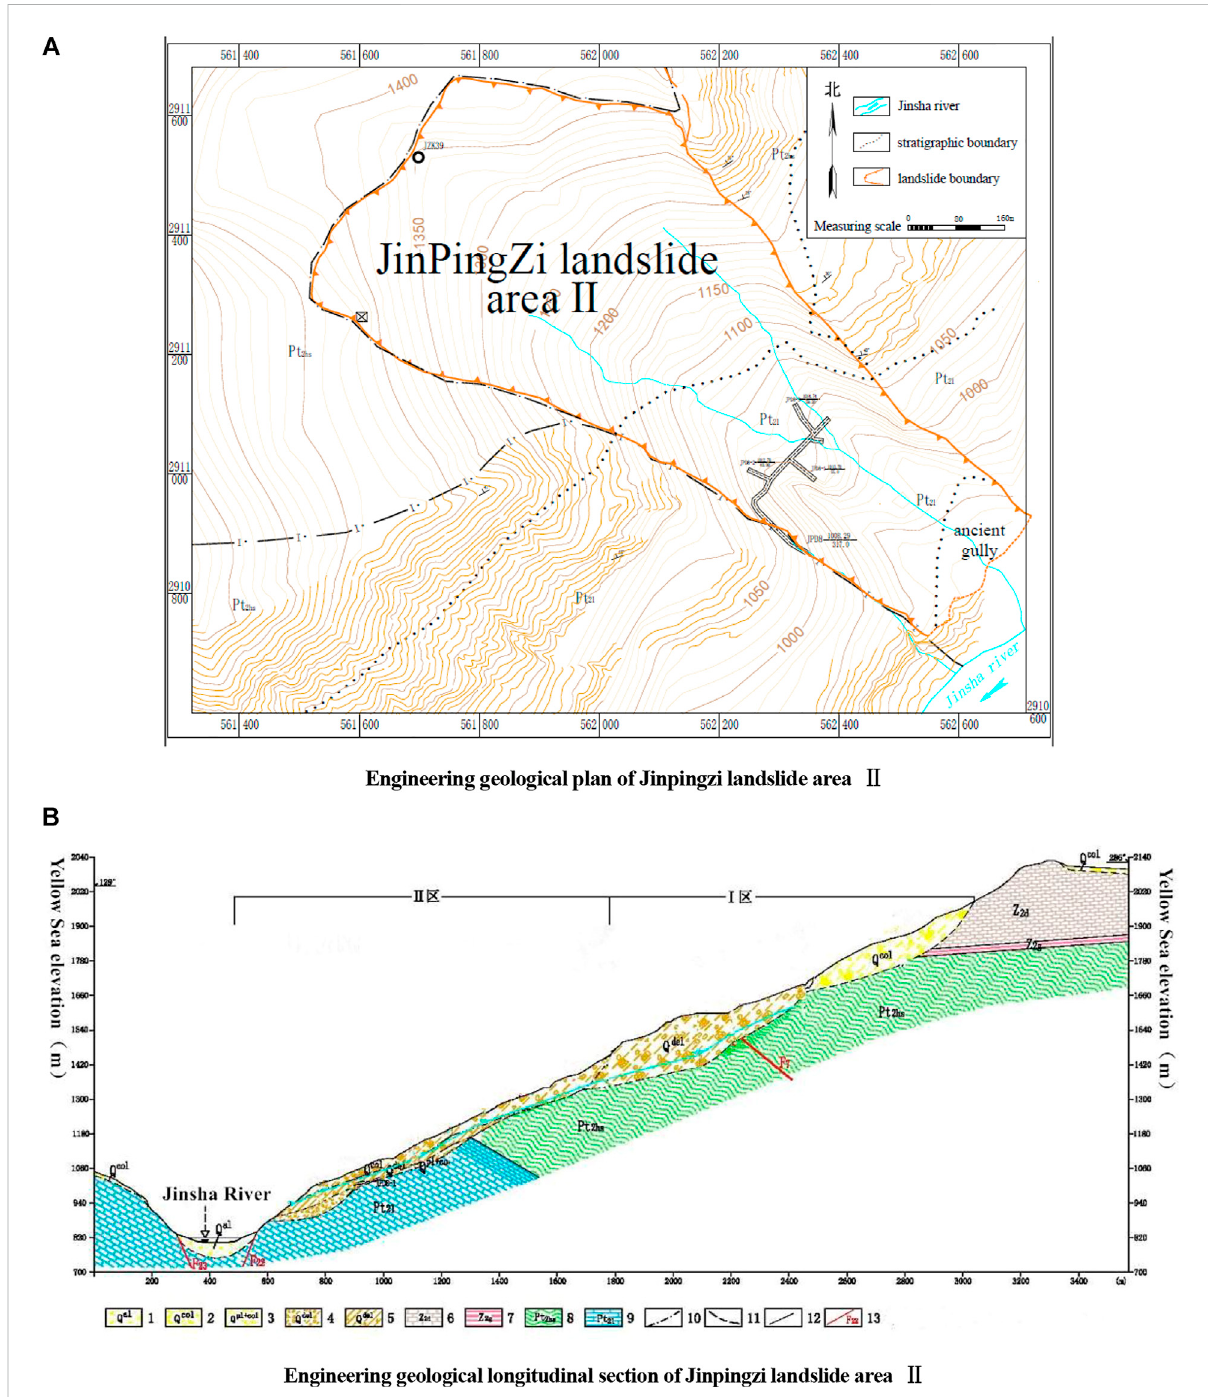
FIGURE 7 Geologicalmapofthestudyarea. (A) EngineeringgeologicalplanofJinpingzilandslideareaII. (B) Engineeringgeologicallongitudinalsectionof Jinpingzi landslide area